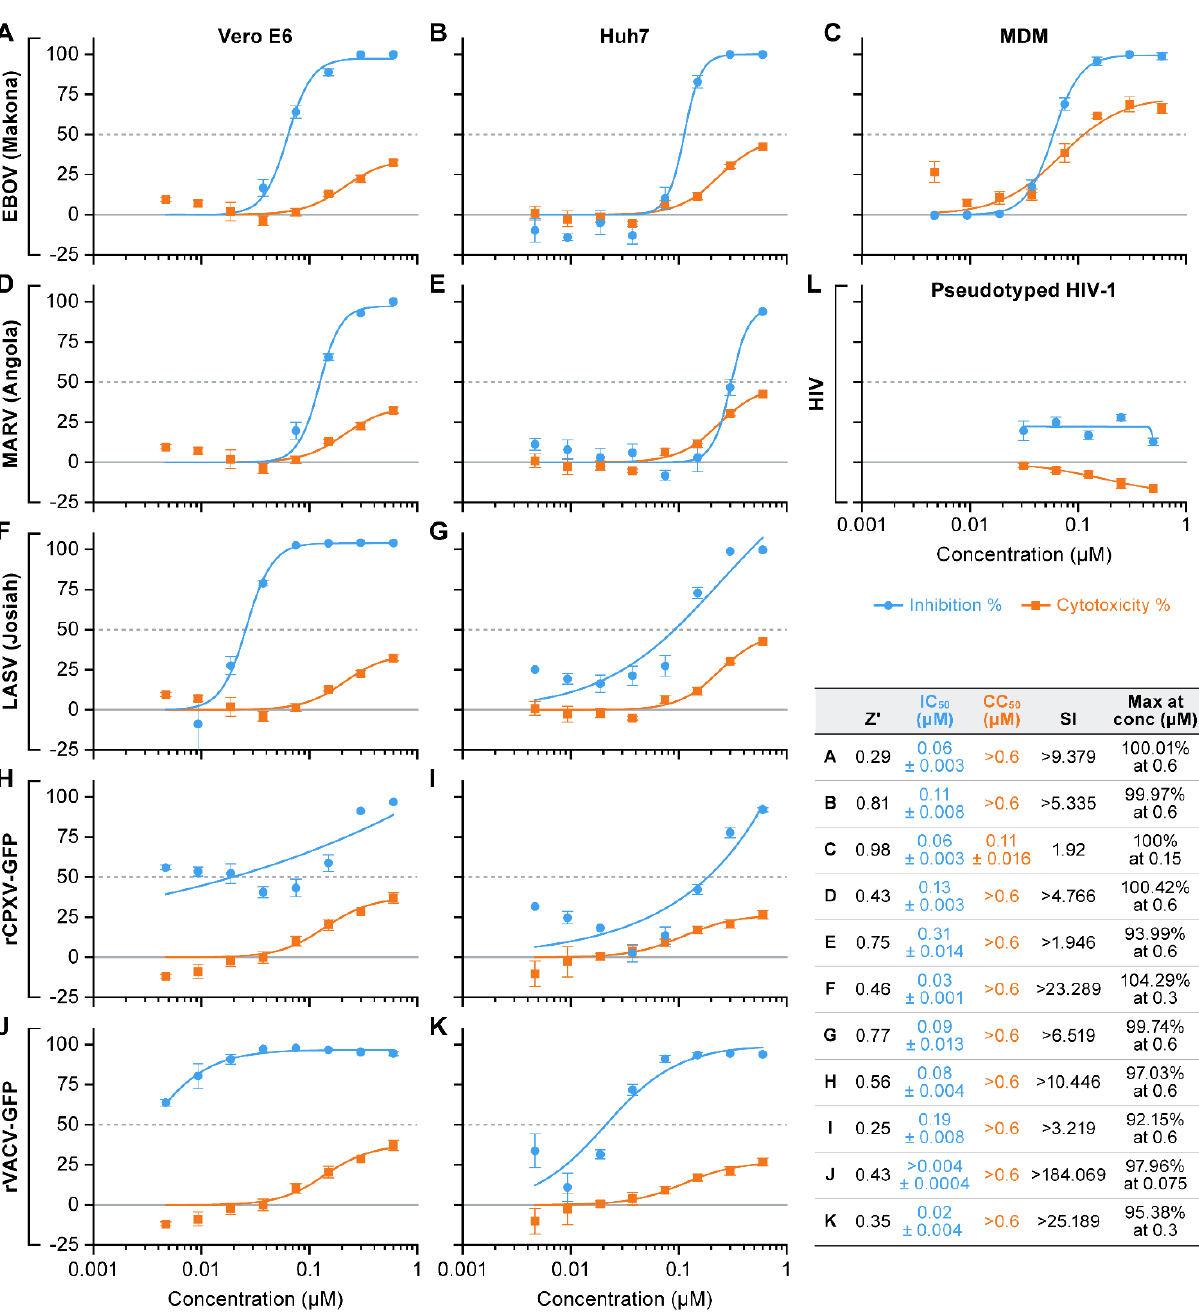
Figure 4. Sangivamycin inhibits the replication of multiple viruses, including EBOV and MARV. ( A – K ) Infectious virus cell-based enzyme-linked immunosorbent assays were performed to determine efficacy and cytotoxicity of sangivamycin in the presence of various viruses. Results are reported as percent inhibition and cytotoxicity relative to untreated controls. Results for each virus tested are shown. ( L ) HIV-1 pseudotype control, TZM-bl cells. Z’ values 0.2 to 1 were considered acceptable. Each concentration was run in triplicate. Plates were run on two separate occasions to ensure reproducibility and agreement between runs. Graphs shown above were generated from one of two runs.